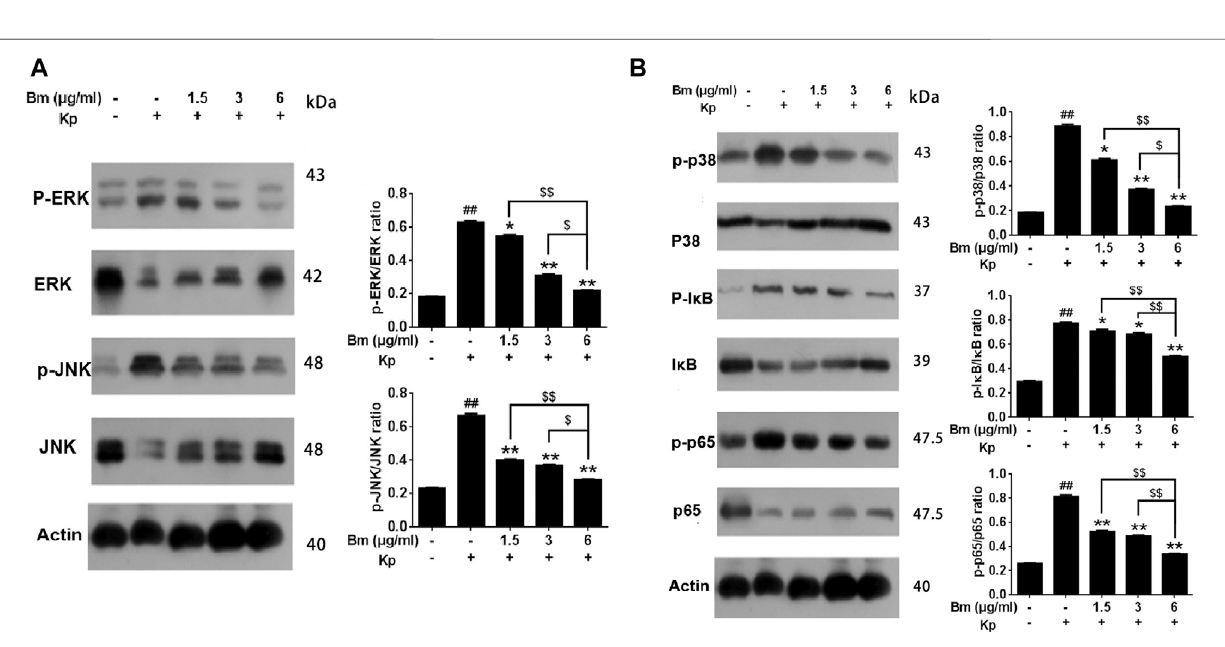
FIGURE7| Effectsof Bergeninmonohydrate ontheNF- κ BandMAPKpathwaysin Klebsiellapneumonia -infectedRAW264.7cellsdeterminedbywesternblotting. Effectsof Bergenin monohydrate on theexpression ofERK, P38and JNK in theMAPK pathway in RAW264.7 cells. Effects of Bergenin monohydrate on the expression of I κ B/P65 in the NF- κ B pathway in RAW264.7 cells (A) Effects on MAPK pathways in Klebsiella pneumonia-infected RAW264.7 cells (B) Effects on NF- κ B pathways in Klebsiella pneumonia-infected RAW264.7 cells. All data are presented as the means ± SEM ( n (cid:2) 5 in each group). ## p < 0.01 vs the Control group; * p < 0.05